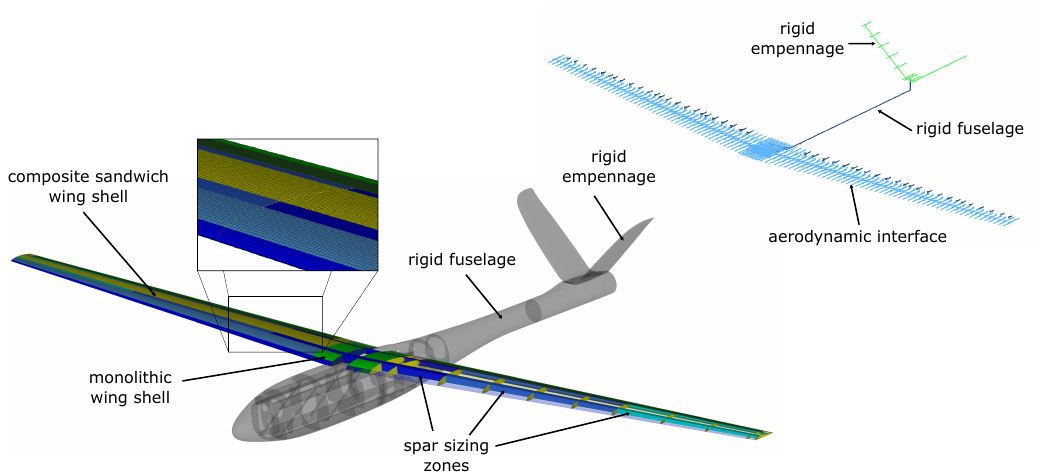
Figure 2. Wing structural layout, Finite Element Model and Aerodynamic